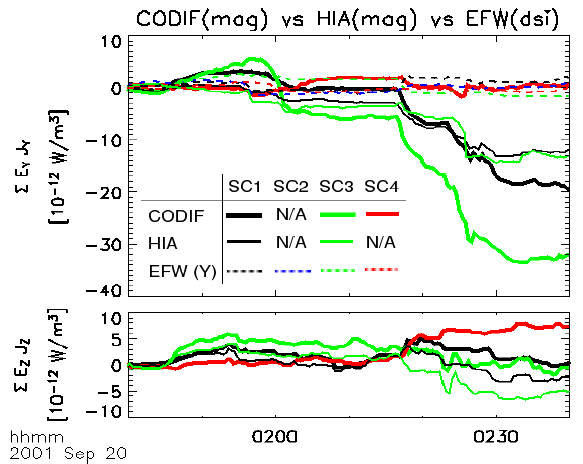
Fig. 11. Cumulative sum of E · J by using the electric field from all available instruments on each spacecraft. The contributions from the Y direction are shown in the top panel and those from the Z direction in the bottom panel. The MAG reference system is used for CODIF and HIA data, DSI for EFW data (only Y direction). The table in the top panel summarizes the colors and linestyles used for each instrument and spacecraft. One notes that the jump in the cumulative sum, indicative for the crossing of a CGR, is mainly exhibited by the Y CODIF and HIA traces on SC1 and SC3. For the discussion of this feature, see the